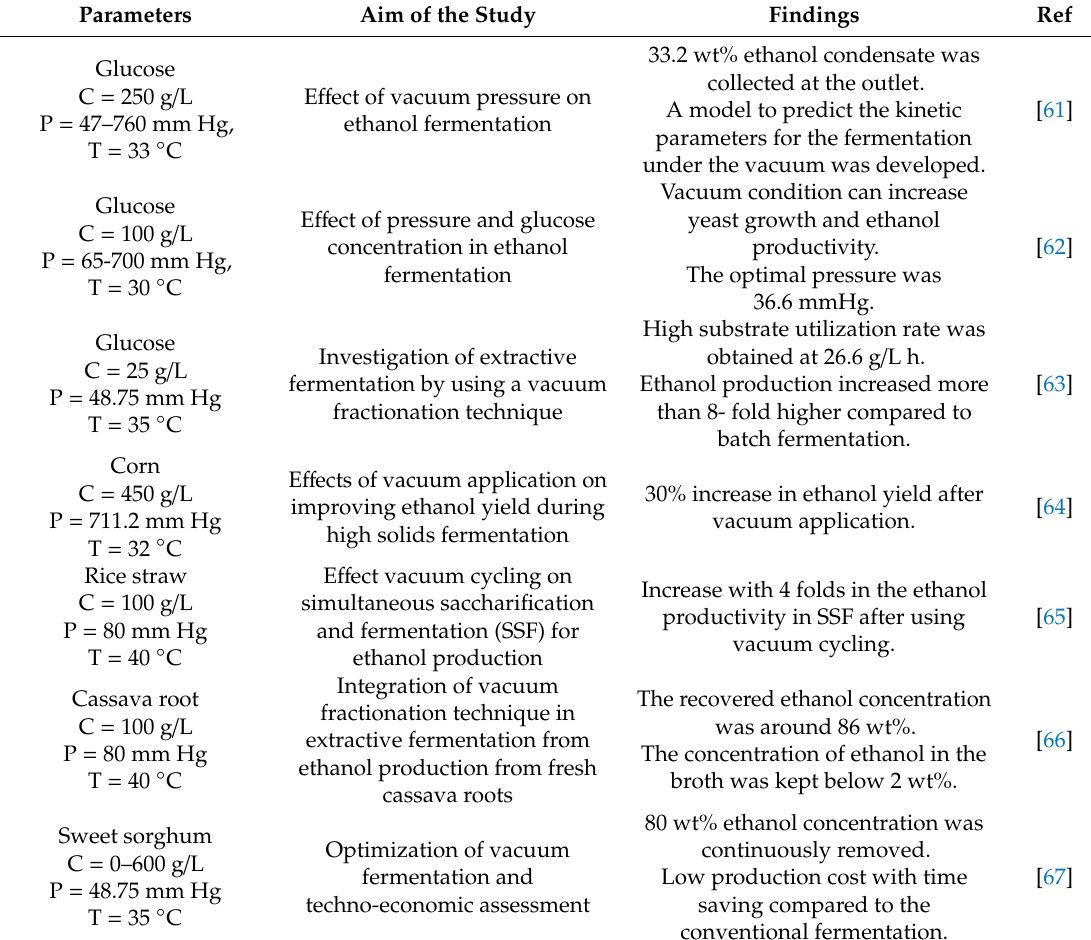
Table 3. Review of studies about ethanol removal using vacuum fermentation (C: Substrate concentration, P: vacuum pressure, T: temperature).